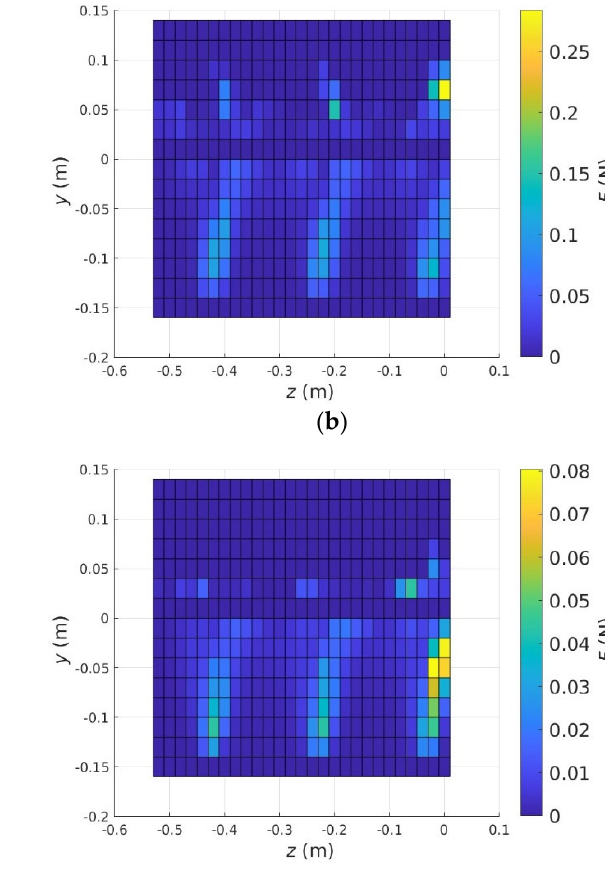
Figure 15. Time ‐ averaged forces acting on particles in a line along z ‐ direction for various paddle angle of 0°, 30°, 45°, and 60°.